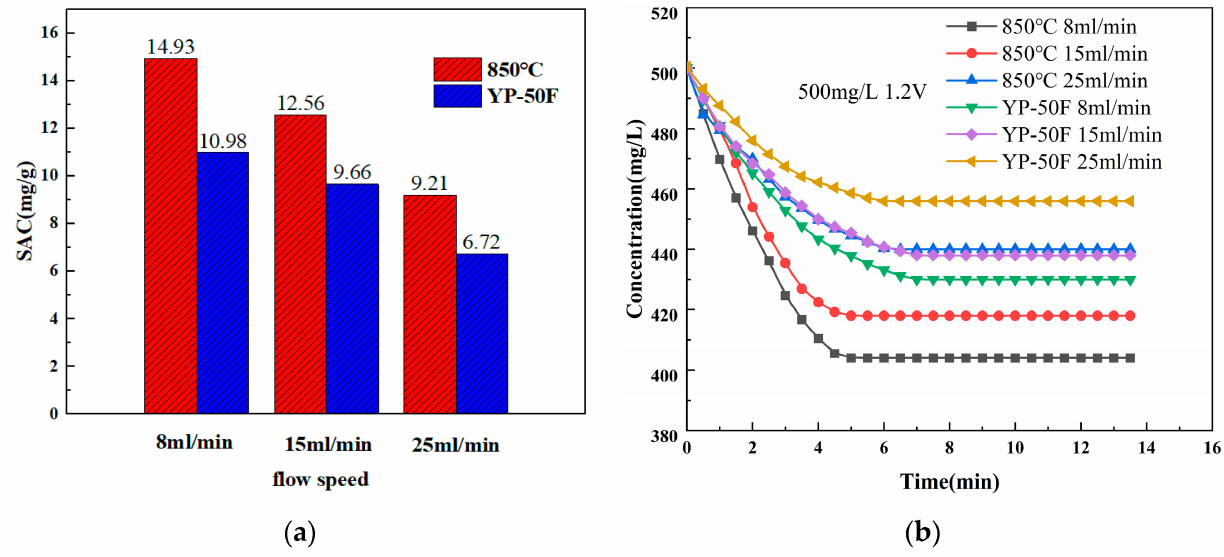
Figure 16. ( a ) SAC of YP-50F and N-doped layered porous carbon at 850 ◦ C pyrolysis temperature. ( b ) Concentration-time curves of N-doped layered porous carbon at YP-50F and 850 ◦ C pyrolysis temperature under different flow rate